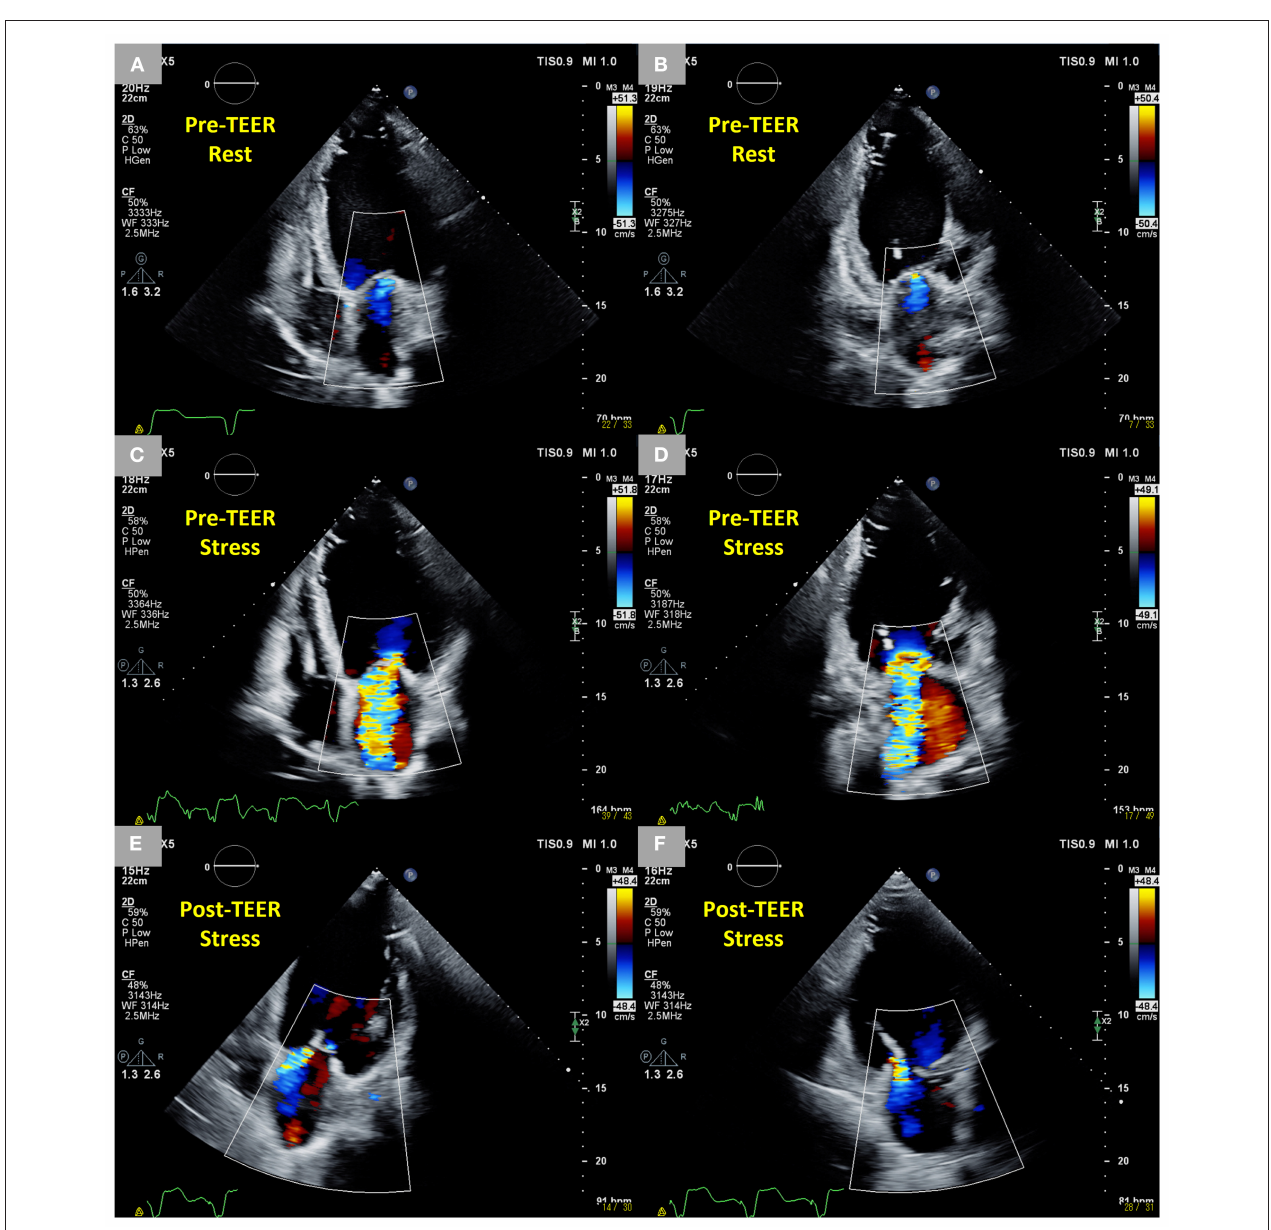
FIGURE 4 | Dynamic changes in SMR during exercise stress echocardiography before TEER and controlled SMR following TEER during exercise stress echocardiography in an 83-year-old male patient who had an anterior and inferior old myocardial infarction and heart failure with reduced ejection fraction after CRT. (A,B) Trivial SMR at rest in two-dimensional color Doppler images from four-chamber and two-chamber views. (C,D) Dynamic severe SMR (EROA 0.52 cm 2 ) under stress in two-dimensional color Doppler images from four-chamber and two-chamber views. (E,F) Mild MR under stress 6 months after the TEER in two-dimensional color Doppler images from four-chamber and two-chamber views. SMR, secondary mitral regurgitation; TEER, transcatheter edge-to-edge repair; CRT, cardiac resynchronization therapy; EROA, effective regurgitant orifice area; MR, mitral regurgitation.